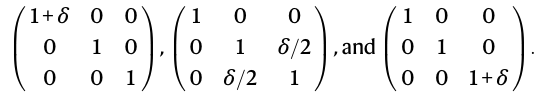
Fig. 4 | Schematic diagram of the IC geomagnetic fi eld and depth-dependent anisotropic texture change in comparison with the calculated velocity aniso- tropy in FeH 0.25 . a Poloidal (B P ) and toroidal (B T ) fi elds in the IC in the meridional plane. B P is shown with red curves in the right sphere, and B T is shown with blue curvesintheleftsphere.Thedashedpurplelineistherotationaxis.Thethickblack lineisthePKIKPraypath.PKIKPreferstothecompressionalwavepathtransmitted throughtheinnercore.TheanglebetweentheraypathandEarth ’ srotationaxisis ξ . The isotropic layer at the UIC is shown with a yellow region. The deeper layer presenting the slowest velocity in the equatorial direction is shown with the blue region. The IMIC with the slowest angle of ~ 45 – 50° from Earth ’ s rotation axis is shown with a green region. b PKPab-PKIKP travel-time residuals 15 as a function of angle ξ arecomparedwiththecalculatedcompressionalwavevelocityanisotropies in the AEP (black curves) and IEP (blue curves) models. PKPab is the reference seismic wave phase traversing only the mantle and outer core. The data travelling from the South Sandwich Islands (SSI) to Alaska are shown with red crosses. c Calculated velocity anisotropy in FeH 0.25 in comparison with the velocities of PREM 52 (1221km, red dashed line) and the anisotropic IMIC (920 – 1221km, green and orange dashed curves) modes 13,38